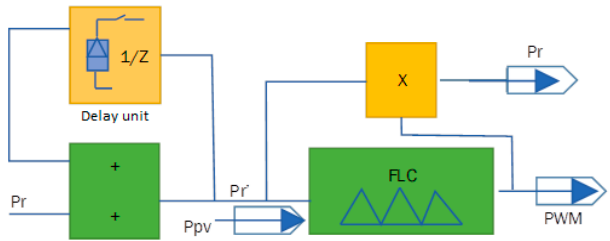
Figure 17. Logic diagram for implementing the control algorithm in MATLAB.